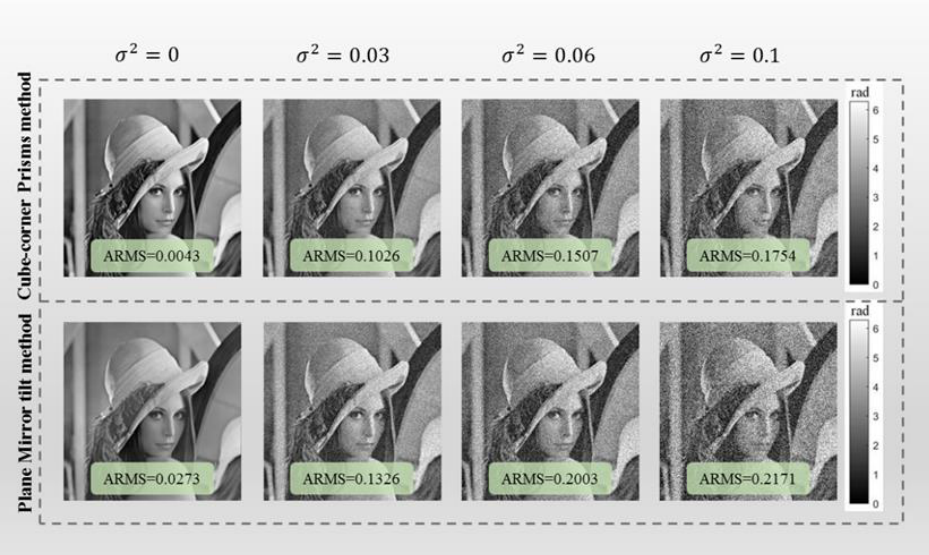
Figure 5. Experimental results of the two methods after adding noise.